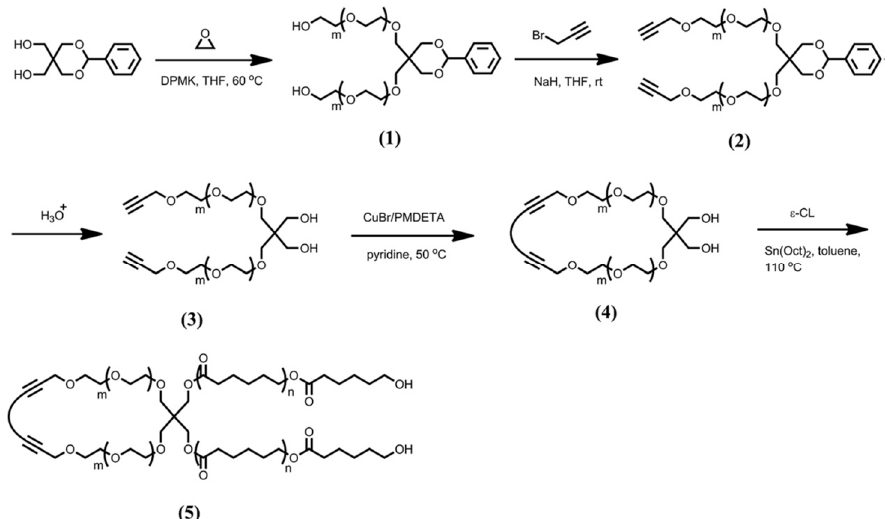
Figure 1. Synthetic route to the tadpole-shaped copolymers (c-PEO)-b-PCL2. Adapted from